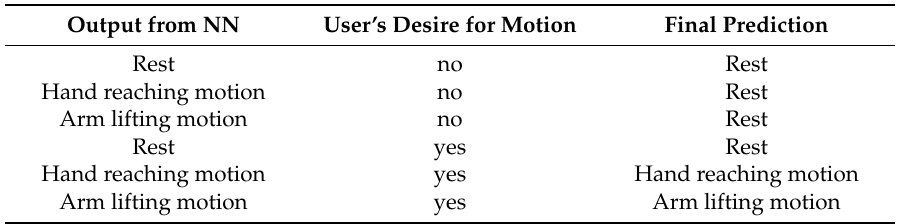
Table 1. Rules of comparison for residual limb motion and the neural network (NN) output. Output from NN